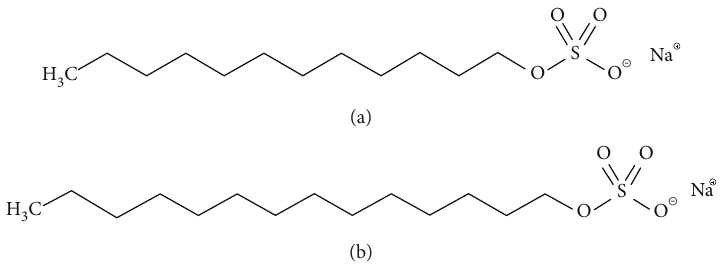
Figure 1: Chemical structures of sodium dodecyl sulfate (SDS) (a) and sodium tetradecyl sulfate (STS)